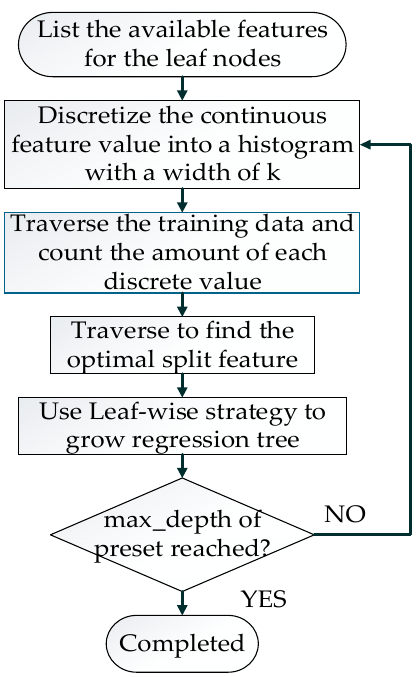
Figure 3. Process of training a regression tree in LightGBM.